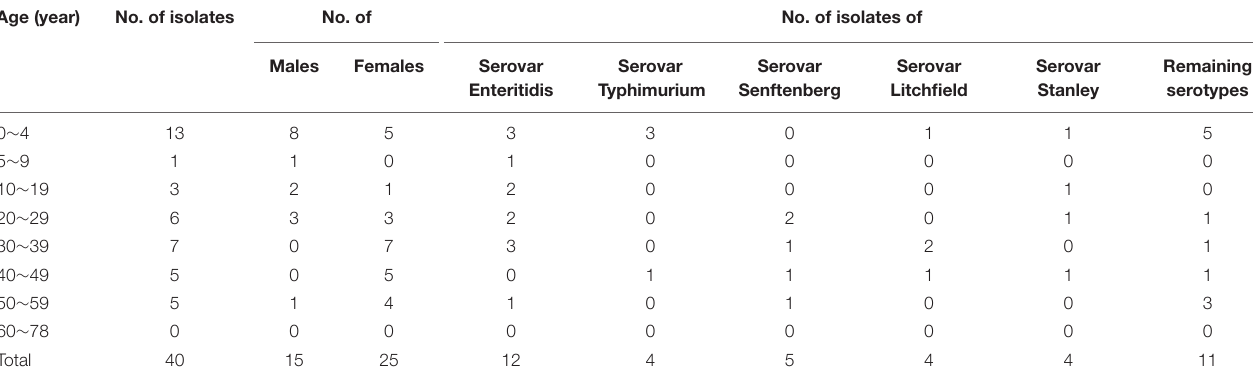
TABLE 5 | Distribution relative to patient age and gender of 40 Salmonella enterica isolates from acute diarrhea infections in Shenzhen, August 2014 through September, 2015. Age (year) No. of isolates No. of No. of isolates of Males